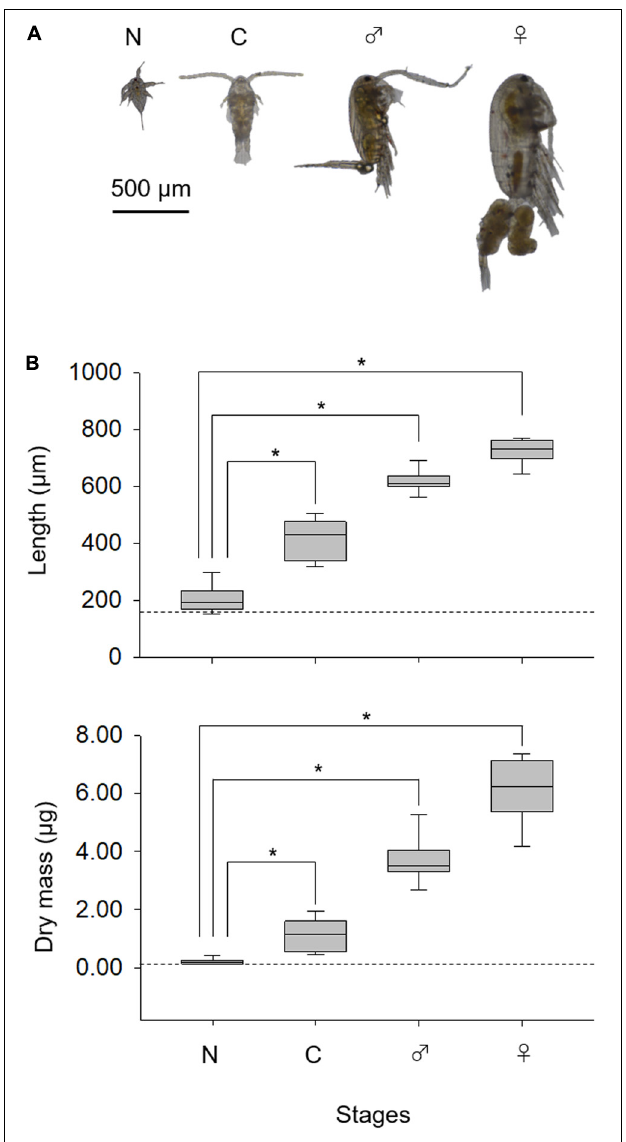
FIGURE 2 | Developmental changes in Pseudodiaptomus inopinus (A) and the lengths and dry mass (B) . Nauplius (N), copepodite (C), adult male ( and female ( ). Nauplius length is expressed as body length; and copepodite and adult length are expressed as prosome length. Broken lines depict ♀ average rotifer lorica length (upper) and dry mass (lower). For box plots, the central line represents the median value, and the box limits are the 25 and 75% quartiles; whiskers cover 5–95% of the data. Asterisks denote significant differences in values (Steel–Dwass test, p <